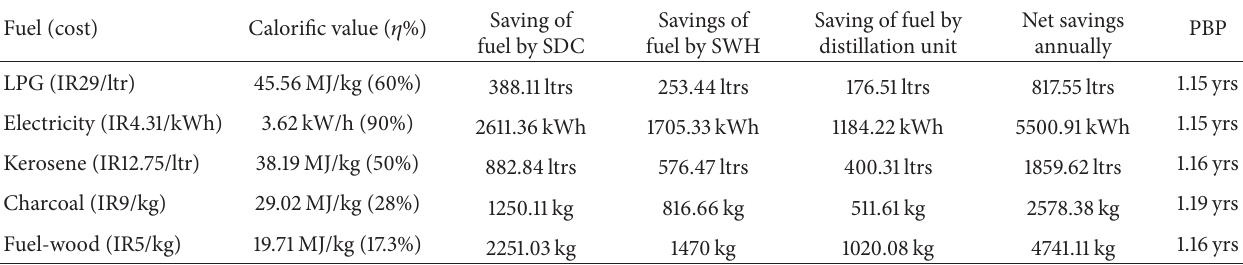
Table 3: Net savings through the present